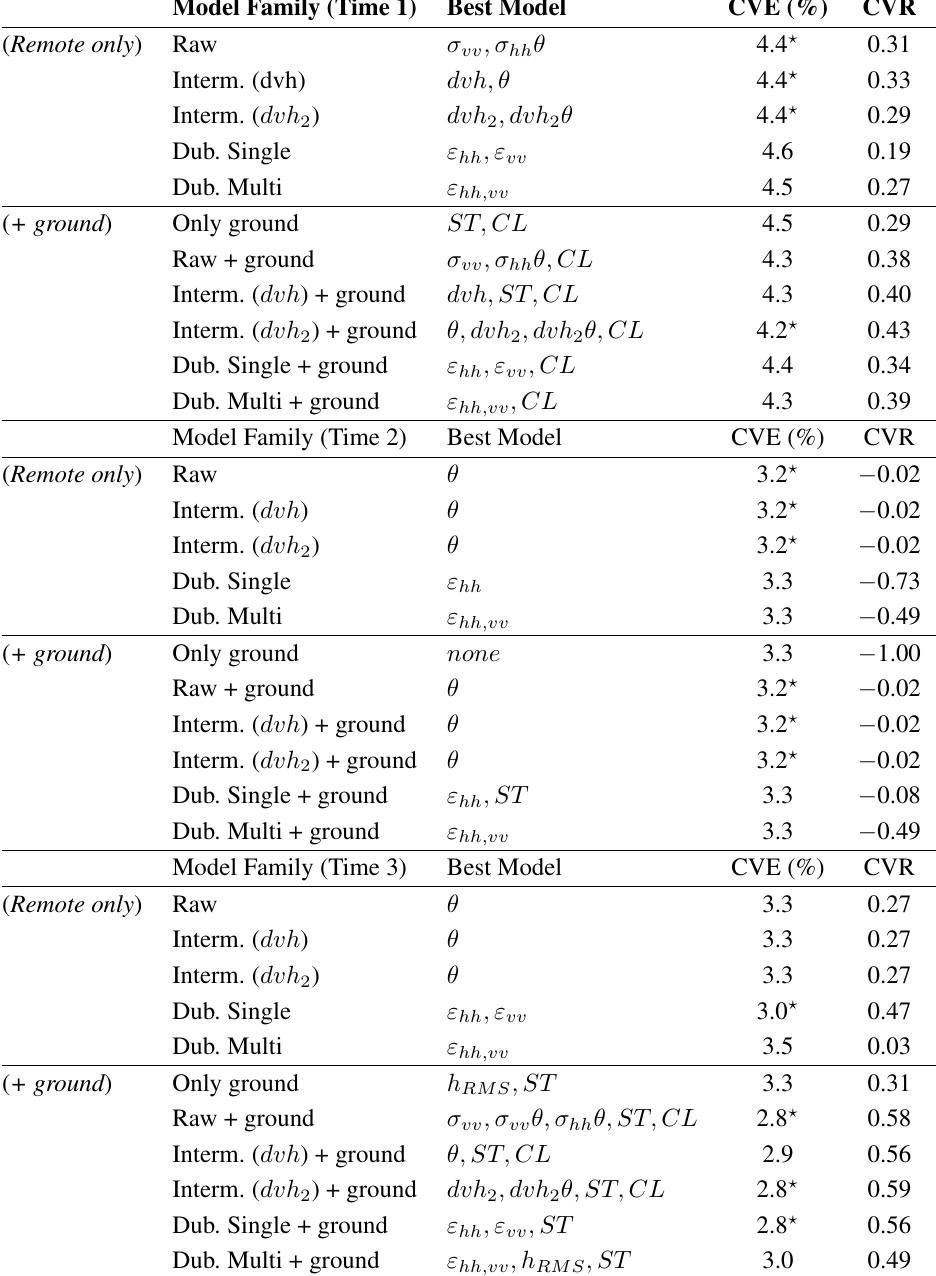
Table 5. Model selection for soil moisture estimation on the ground at Time 1 (5 May), Time 2 (16 May) and Time 3 (23 May). CVE in the table stands for the mean square cross-validation error and CVR stands for cross-validated correlation. The best model(s) for each time point is denoted by a